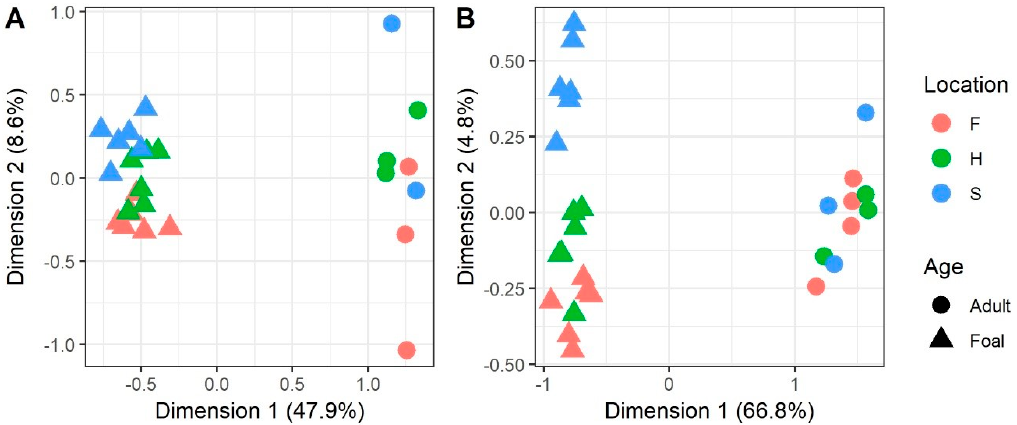
Figure 1. Multidimensional scaling (MDS) was run on normalized gene expression values (logCPM) after removing the effects of the surrogate variables to cluster the ( A ) articular cartilage samples; and ( B ) subchondral bone samples to get an overview of similarities and differences between samples. Each samples’ age and location are indicated by point shape and color, respectively. Locations are F = fetlock (metatarsophalangeal joint), H = hock (tarsocrural joint), and S = stifle (femoropatellar joint).